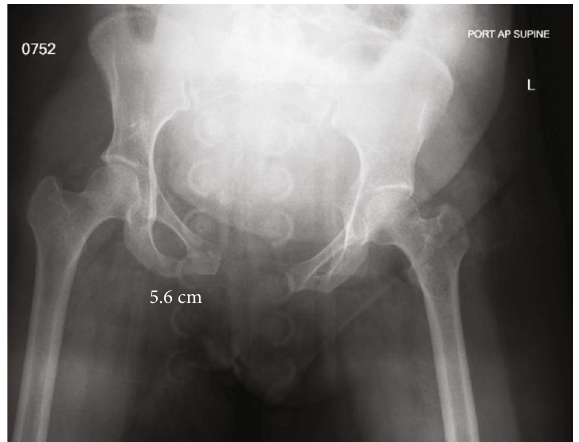
Figure 1: Diagnostic AP pelvis radiograph demonstrating a traumatic pubic ring separation of 5.6cm.